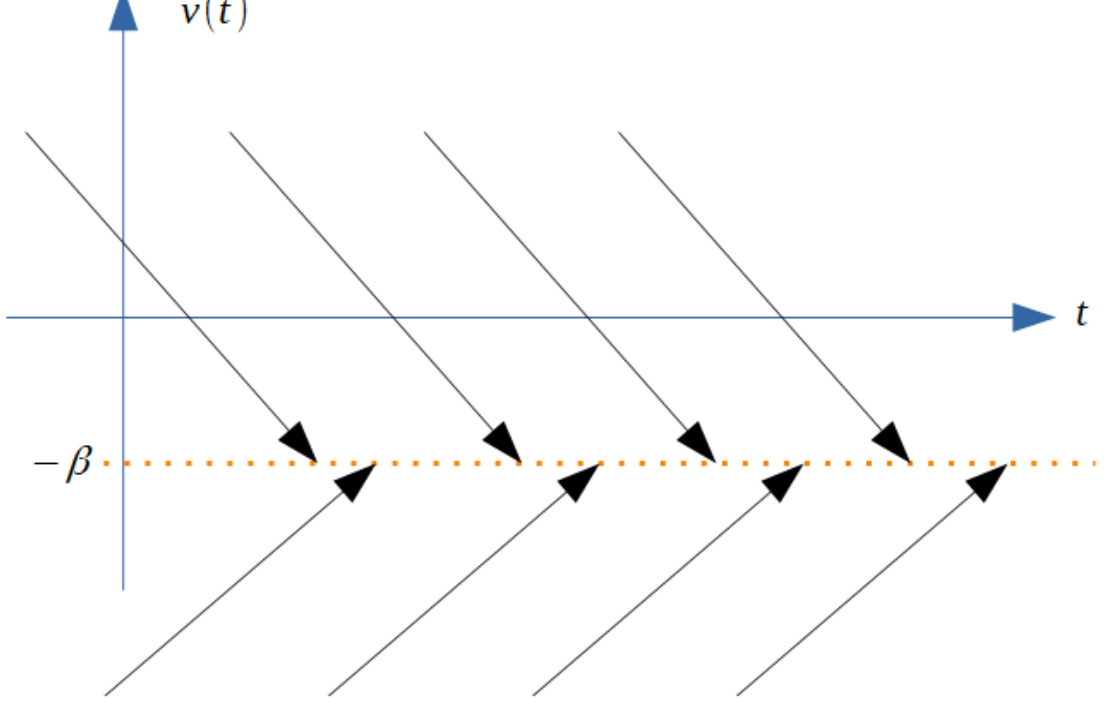
Figure 16. Phase trajectories of the closed-loop system